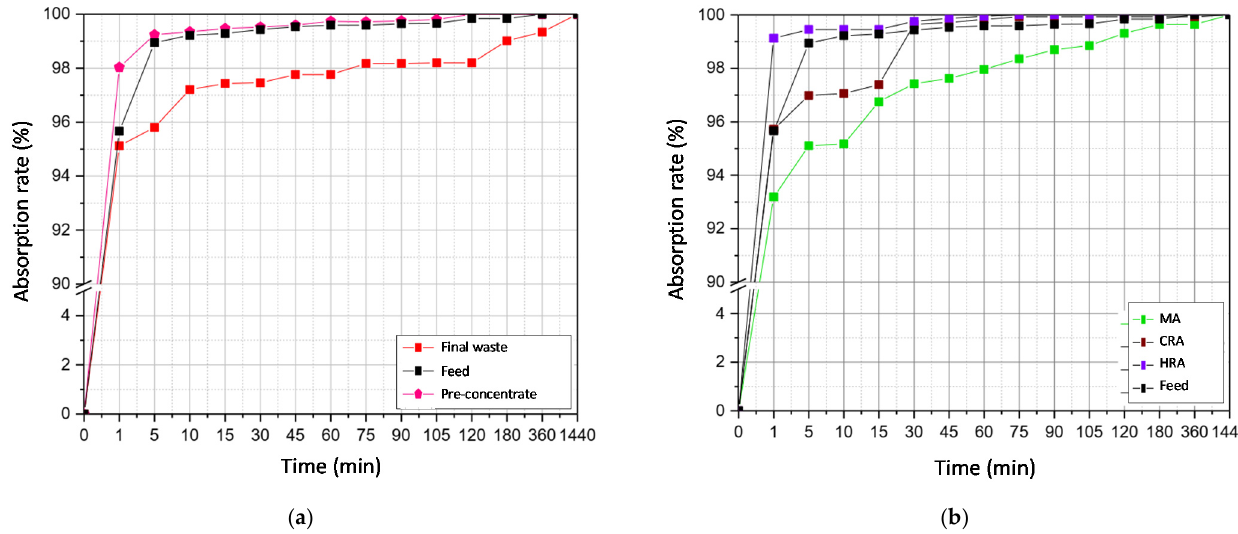
Figure 9. Relative water absorption over time. ( a ) Products from the first jigging stage. ( b ) Products from the second jigging stage.